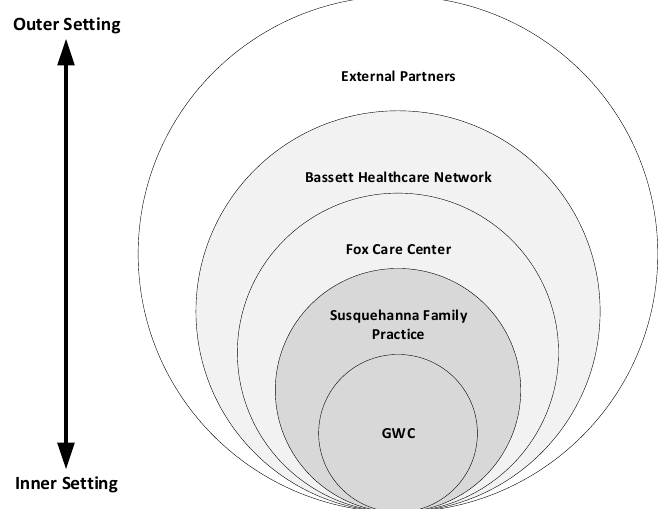
Figure 3. Depiction of the structure within which the GWC is embedded. For the purposes of this study, the GWC and Susquehanna Family Practice (dark grey) were considered the inner-most setting, with Fox Care Center and the Bassett Healthcare Network (light grey) displaying qualities of both the inner and outer settings, and partners external to Bassett Healthcare Network (white) in the outer-most setting.